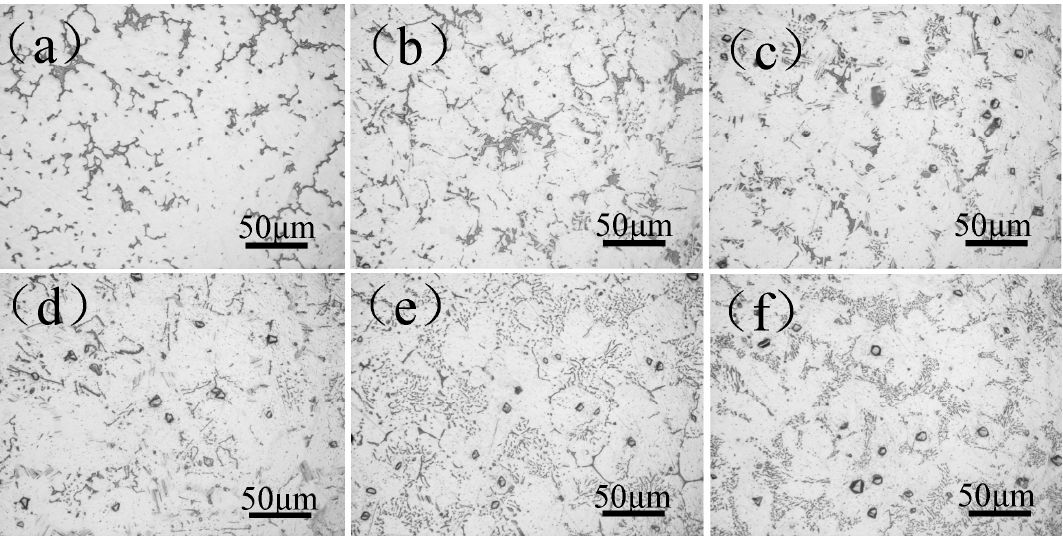
Figure 3. Metallographic microstructure of as-cast Mg-11Gd-2Y-1Zn-xAl alloys. ( a ) x = 0; ( b ) x = 1; ( c) x = 2; ( d ) x = 3; ( e ) x = 4; ( f ) x = 5.